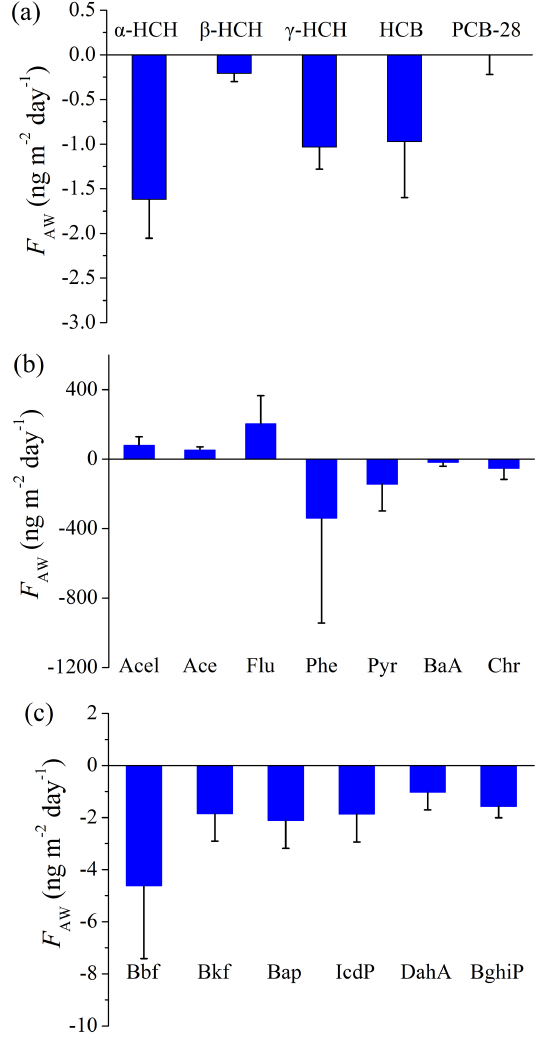
Figure 7. Average air–water gas exchange fluxes ( F AW ) for individ- ual OCPs, PCB 28 (a) , and PAHs (b, c) in Nam Co lake. Positive values indicate net volatilization, and negative values indicate net deposition.